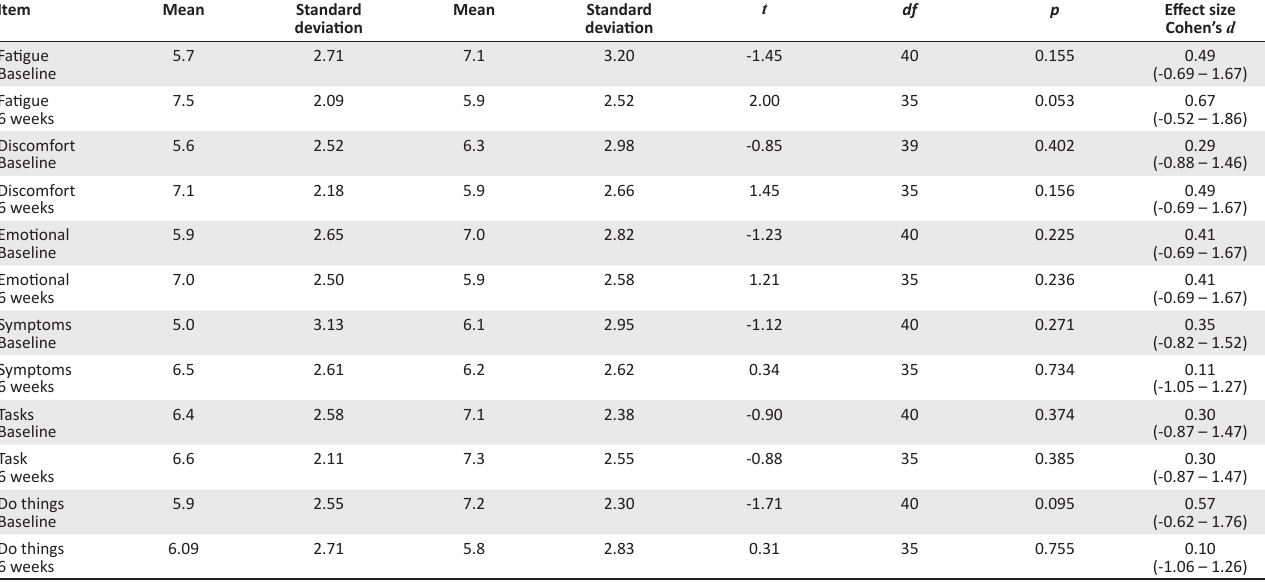
TABLE 5: Between-group differences from baseline to 6 weeks in the self-efficacy scale. Item